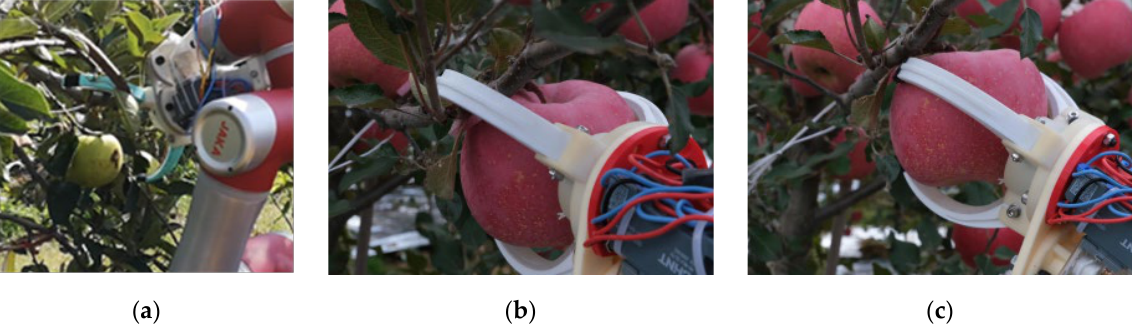
Figure 2. Problems encountered by apple-picking robots during the gripping process: ( a ) end-effector stuck in a tree branch; ( b ) end-effector grabs both the apple and the branch; ( c ) end-effector grabs the apple perfectly.